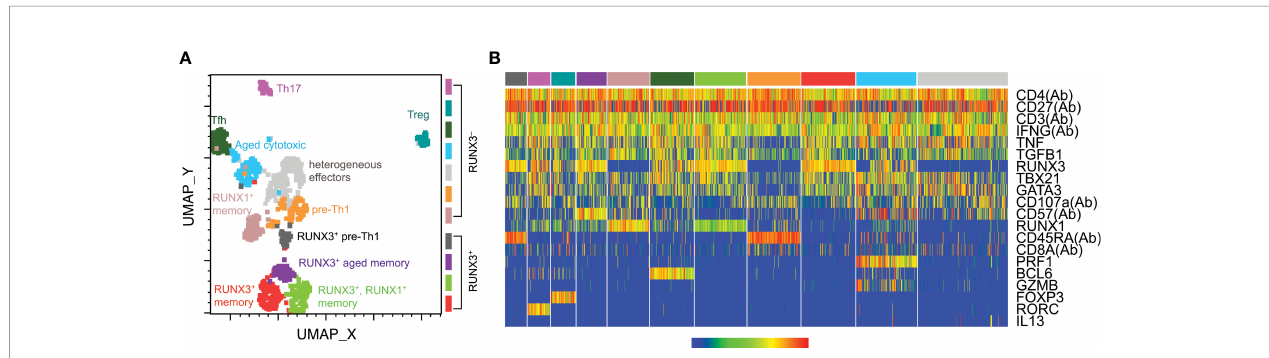
FIGURE 2 | CMV-responsive CD4 T cell cluster classi fi cation. CD4 T cells from six transplant recipients were stimulated with CMV IE-1 peptide for 5 hours and IFN g -positive cells sorted for single-cell targeted PCR and sequencing as described (26, 31). Data for 20 detected genes were batch-corrected as described (26). Cells were gated as CD4 + in SeqGeq and concatenated for analysis. Seurat was run in SeqGeq for dimensionality reduction and clustering. (A) UMAP dimensionality reduction color-coded by the Seurat clusters, with cluster names as de fi ned in part (B) found on the plot. (B) Seurat generated heatmap displaying gene expression of each cluster. Parameters with (Ab) were detected at the protein level, and the others were detected at the RNA level. Classi fi cations were assigned based on gene expression patterns. n=6